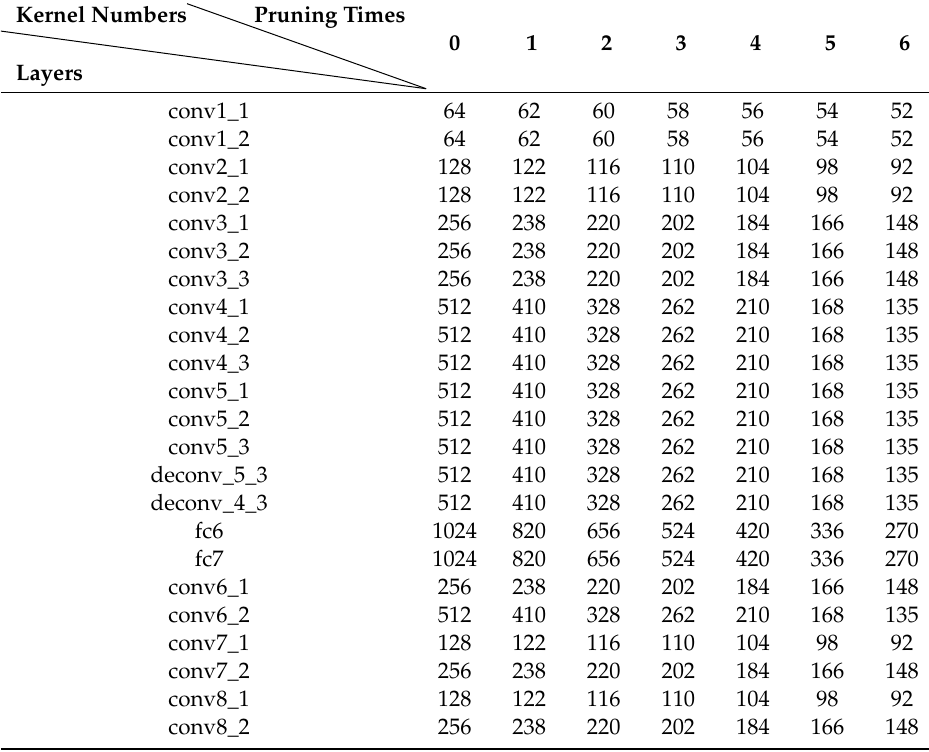
Table 3. SSD network structure with six recursive prunings.